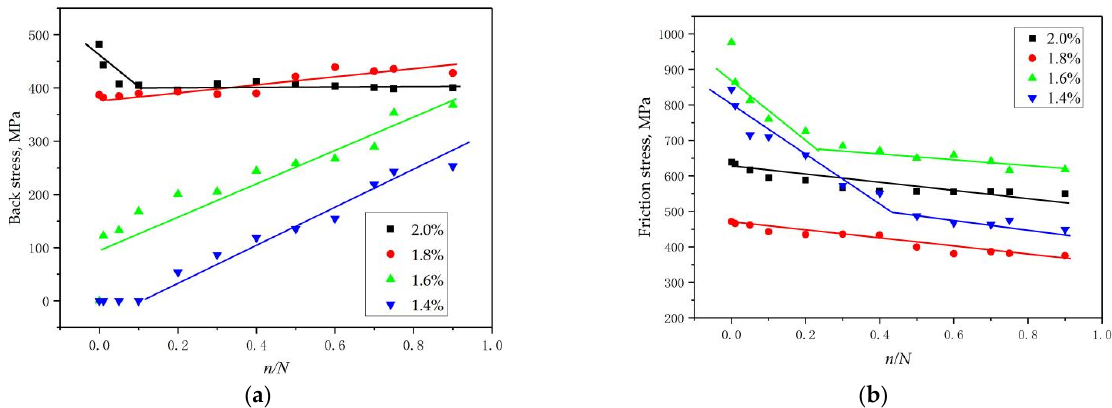
Figure 10. The evolutions of back stress and friction stress with n / N at different strain amplitudes: ( a ) back stress; ( b ) friction stress. ( a ) back stress; ( b ) friction stress.